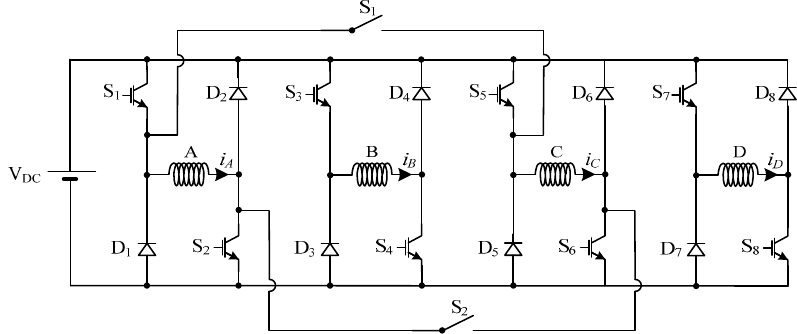
Figure 25. Fault-tolerant topology proposed by [90] using a healthy leg to control two phases not in sequence. This solution requires static switches to establish the connection between phases.